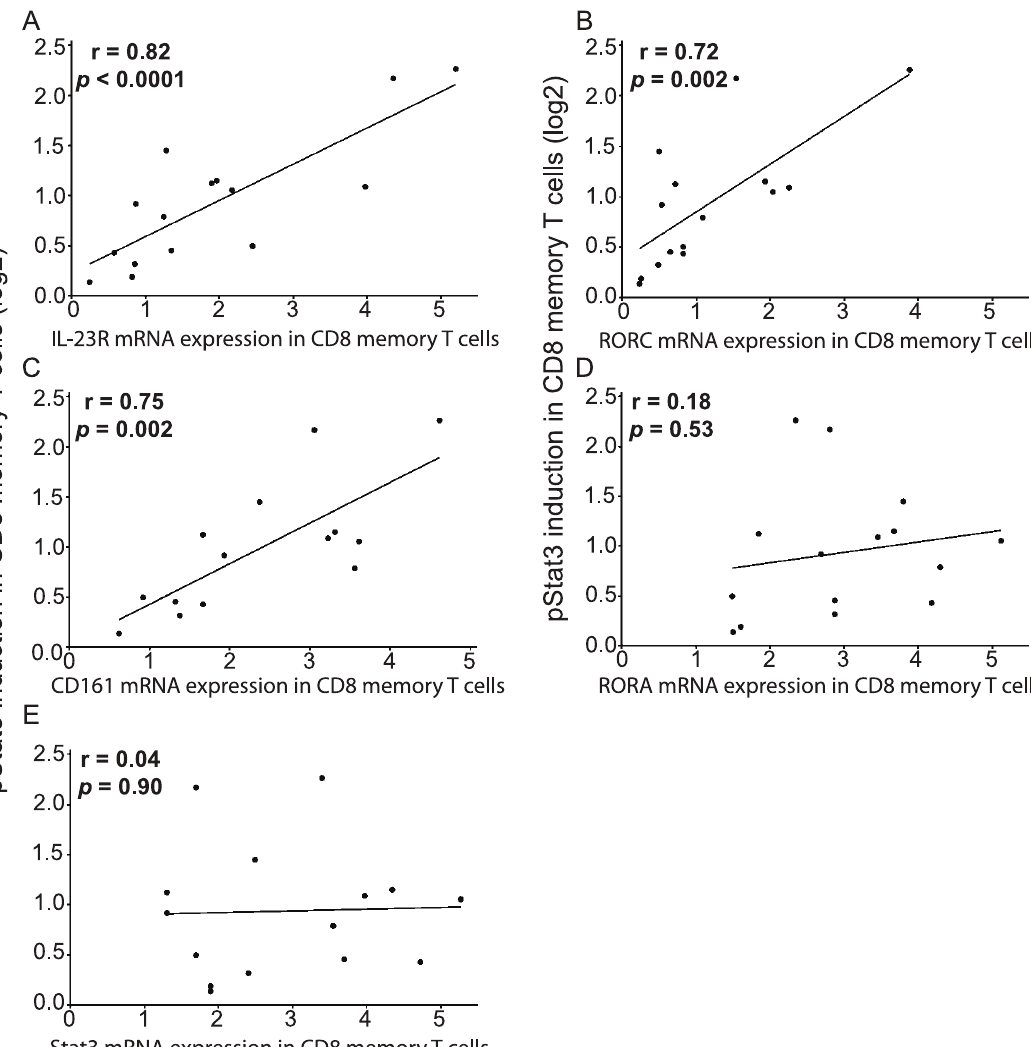
Figure 4. IL-23 responsiveness in CD8 + CD45RO + memory T cells is correlated with IL-23R, RORC and CD161 mRNA expression. Quantitative RT-PCR assays were performed in FACS-sorted CD8 + CD45RO + memory T cells from 15 individuals selected for having a range of IL-23 responsiveness, which were measured by whole blood phospho-flow assays for IL-23-mediated pSTAT3 induction (log2). Correlations were assessed between IL-23 responsiveness and (A) IL-23R, (B) RORC, (C) CD161, (D) RORA, and (E) STAT3 mRNA